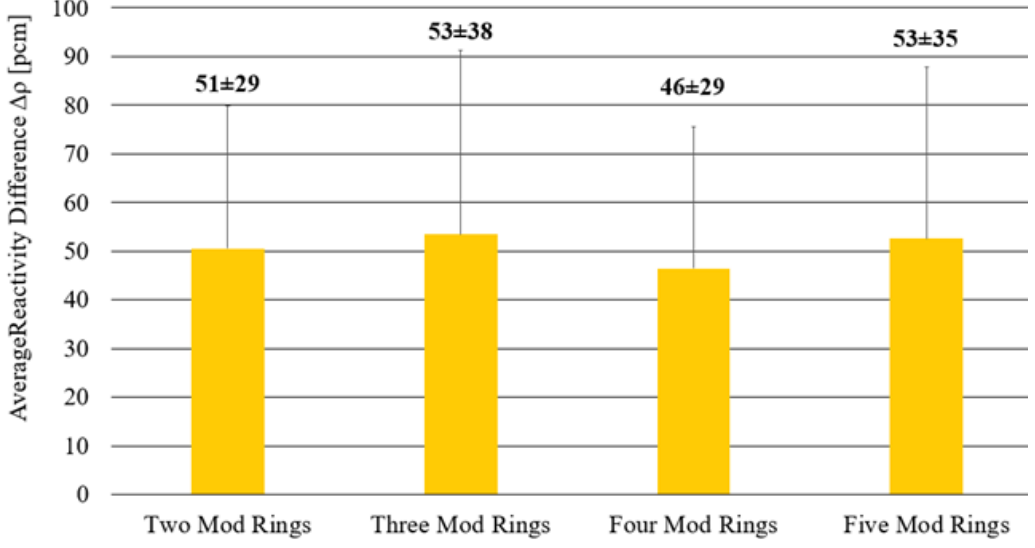
Figure 13. Average difference from McCARD k inf and standard deviation for single pin moderator mesh